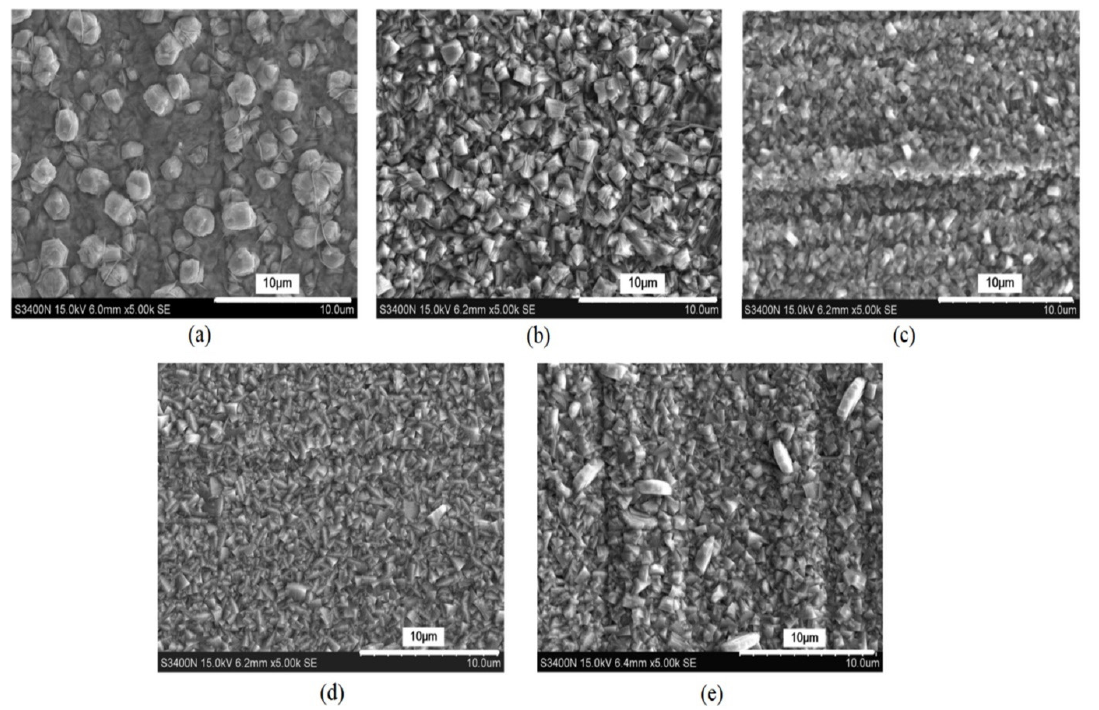
Figure 6. Surface morphology of nanocoating at varying concentrations of CPAM ( a ) 5, ( b ) 10, ( c ) 15, ( d ) 20, and ( e ) 25 g/L [102].